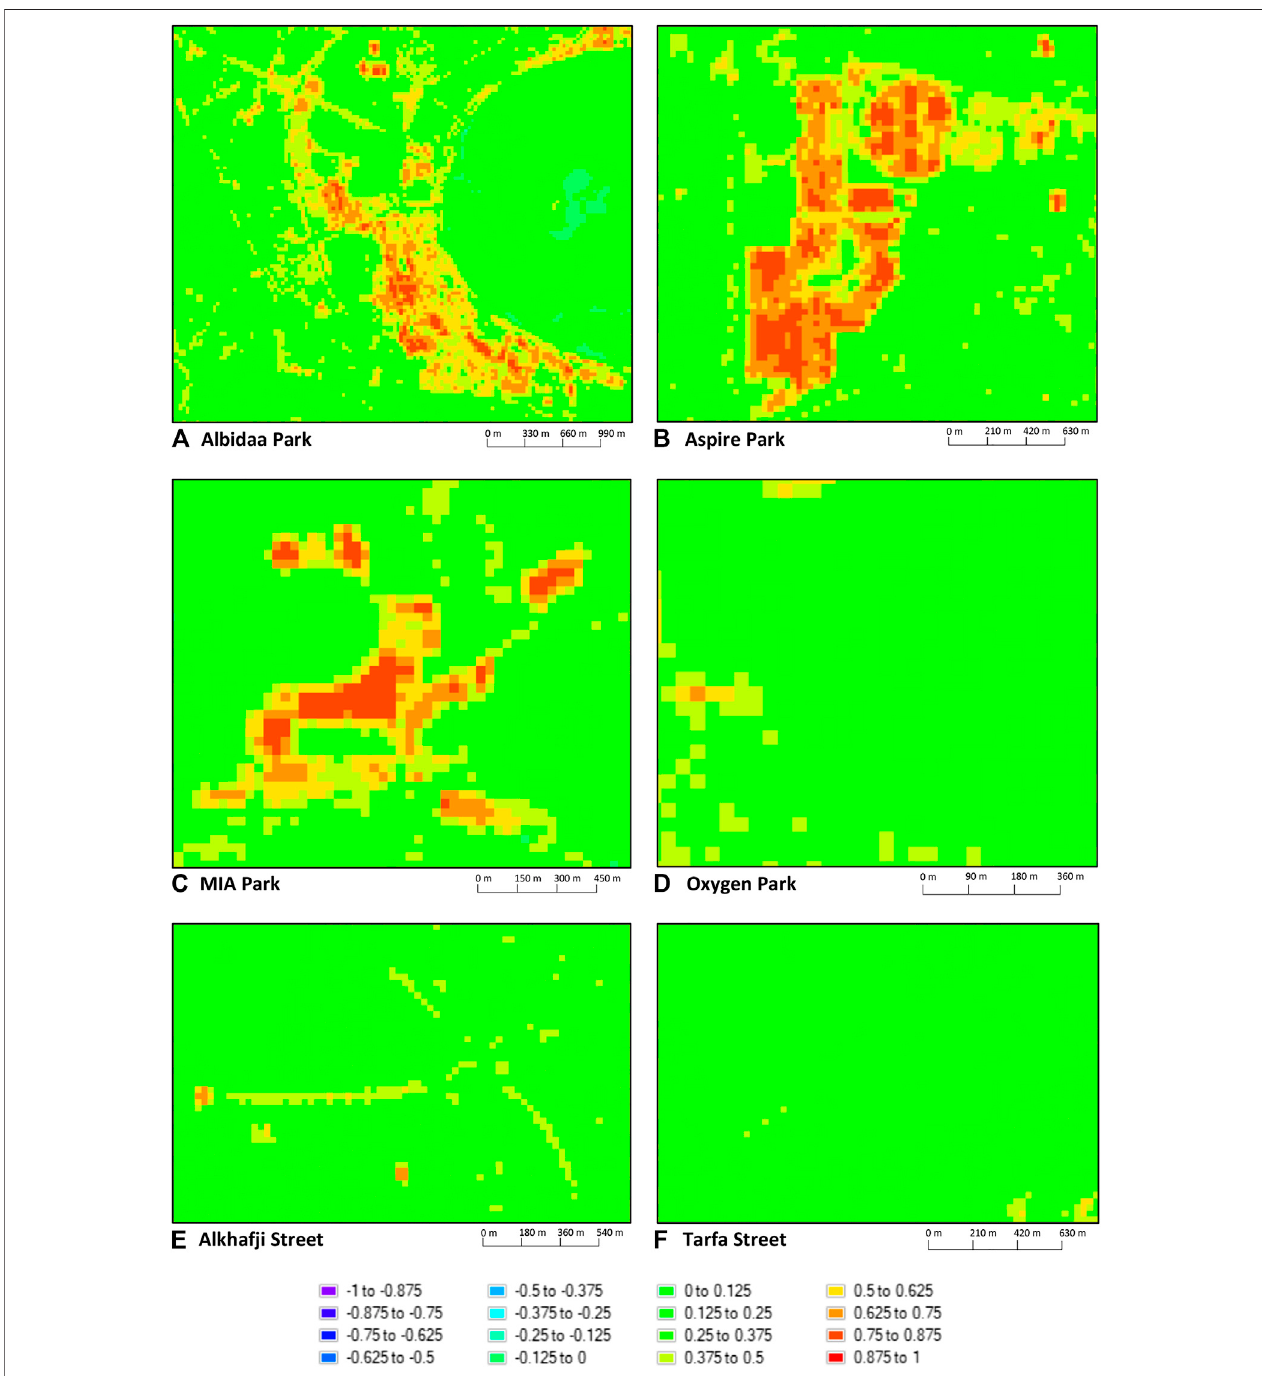
FIGURE11| Normalizeddifferencevegetationindex(NDVI)mapsoftheselectedland-usetypesbasedontheimagesacquiredfromLandsat8OLIonMay23,2014.